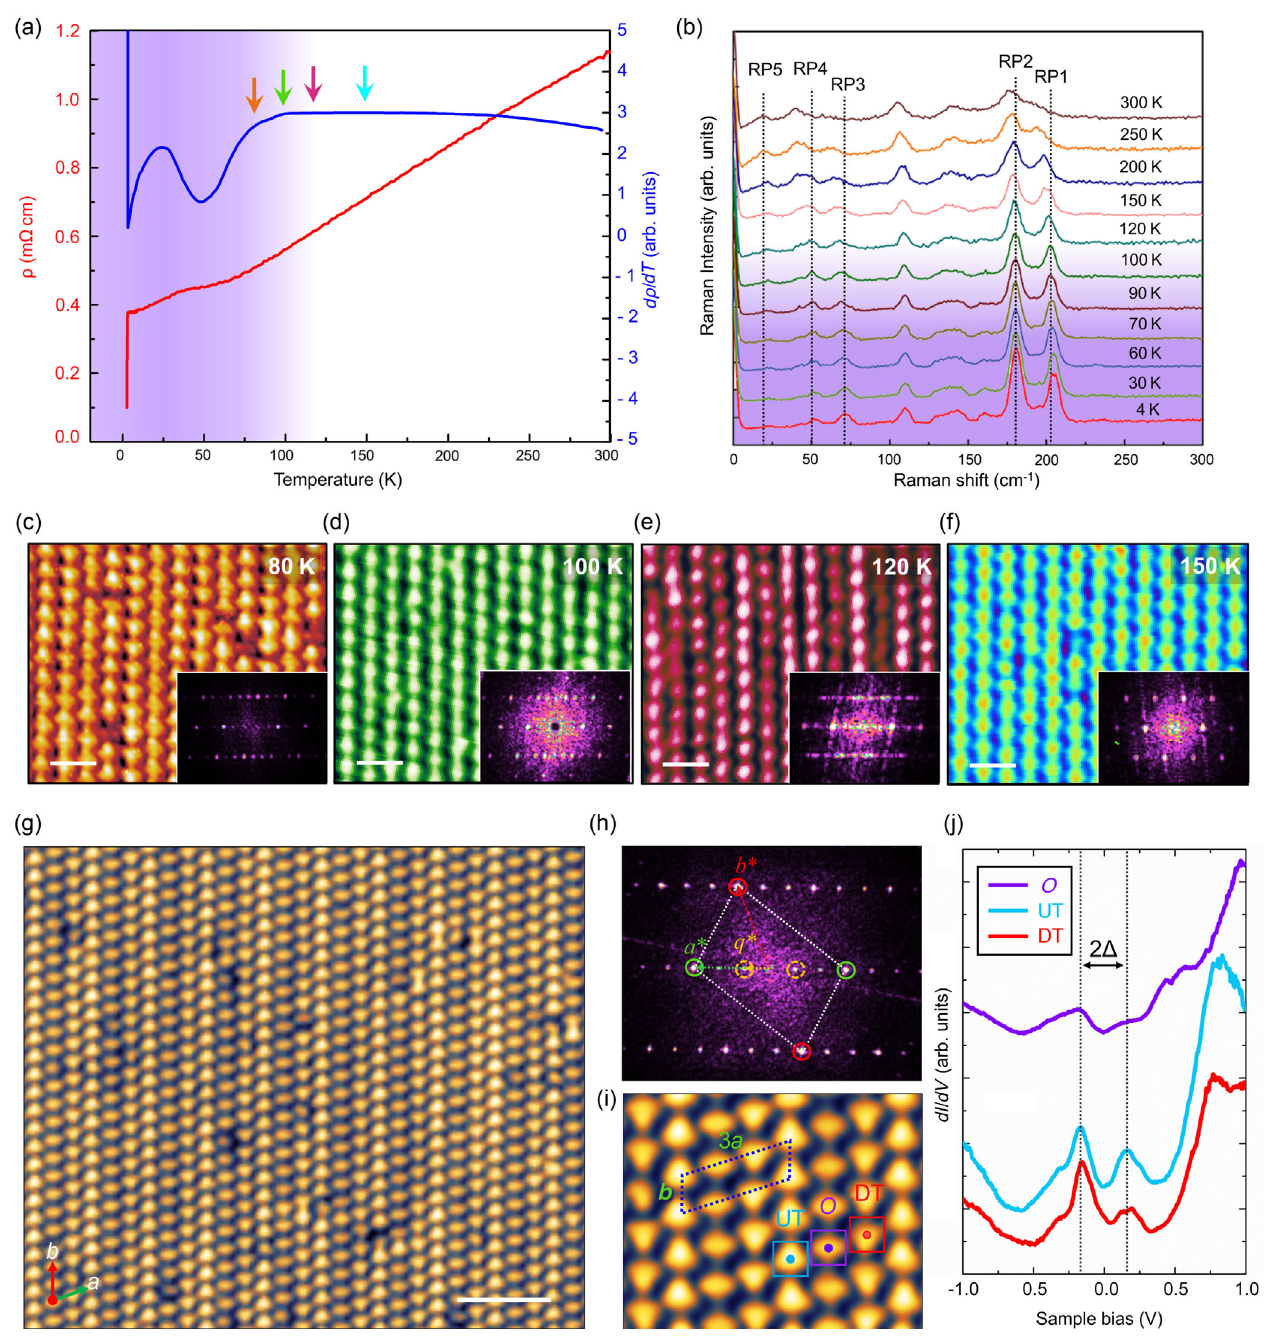
FIG. 2. Charge order transitions in the ATS superatomic crystal. (a) Temperature-dependent resistivity (red) and its derivative (blue) curves. (b) Temperature-dependent Raman spectrum. Five temperature-dependent Raman peaks are marked as RP1 – 5. (c) – (f) STM topographies and corresponding FFT patterns obtained at 80 K (c), 100 K (d), 120 K (e), and 150 K (f), which are marked by the color-coded arrows in (a). (g) Large-scale STM topography at 9 K. (h) The corresponding FFTof (g). The green and red circles mark the Bravais vectors ( a (cid:3) and b (cid:3) ) of the pristine a - b plane layer, respectively. The orange circles mark the Bravais vectors ( q (cid:3) ¼ a (cid:3) = 3 ) of the triple stripe charge order.(i)High-resolutionSTMimageforthe 3 × 1 supercellofthetriple-cubeCDW.(j)STSspectraoftheUT, O ,andDTcubeunitsshowing a charge order gap of approximately 0.17 eV. (g) Scale bar 5 nm, Vs ¼ þ 1 . 2 V. (h) Scale bar 2 nm, Vs ¼ þ 1 . 2 intersects bands 3 (light green) and 4 (light pink), which four bands correspond to the intercube bonding states along opens two small gaps of 10 meV around points 1 = 3 ( Γ - X ) the b axis, which are hybridized between four pairs of Te and 2 = 3 ( Γ - X ) in the 2D BZ, respectively, and leaves a flat atoms on the two facing planes of two adjacent cubes band nearly sitting at the E F between them. Its bandwidth (Supplemental Material Fig. S6 [38]). Band 5 (orange)